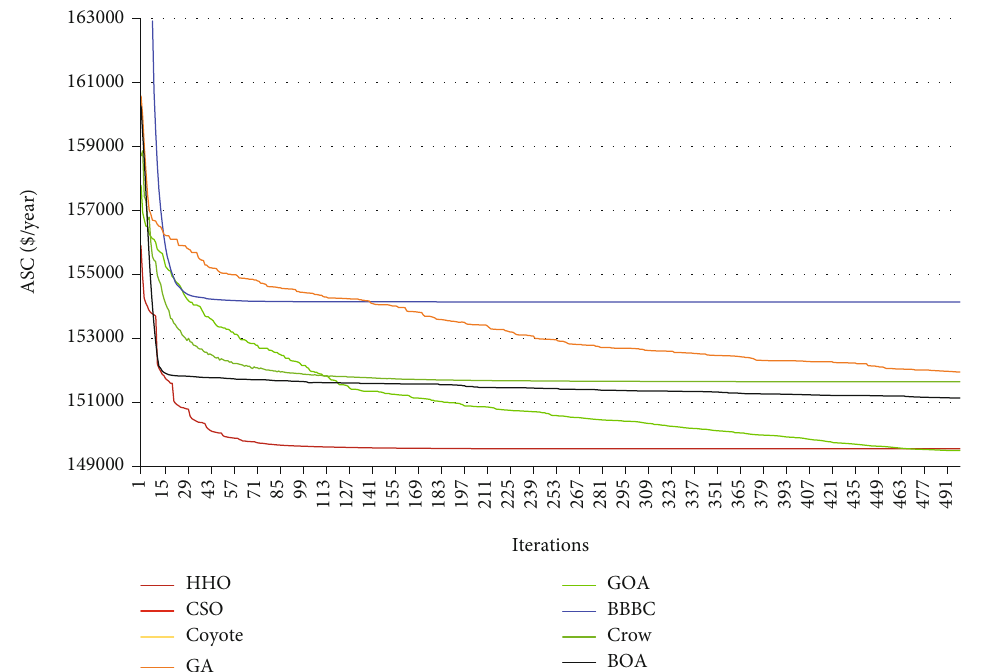
Figure 7: Convergence rate of the HHO compared with the other optimization algorithms.